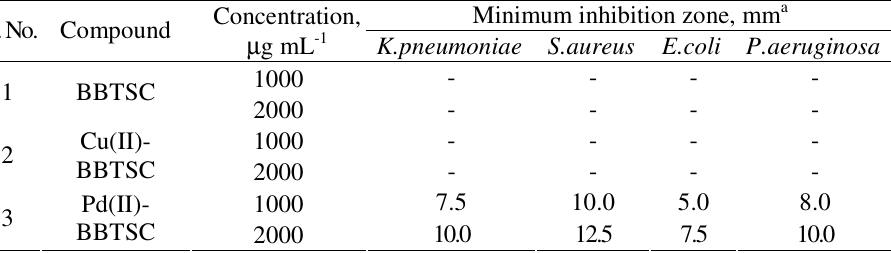
Table 2. Antibacterial activity of 3,4-DHBINH and its complexes S.